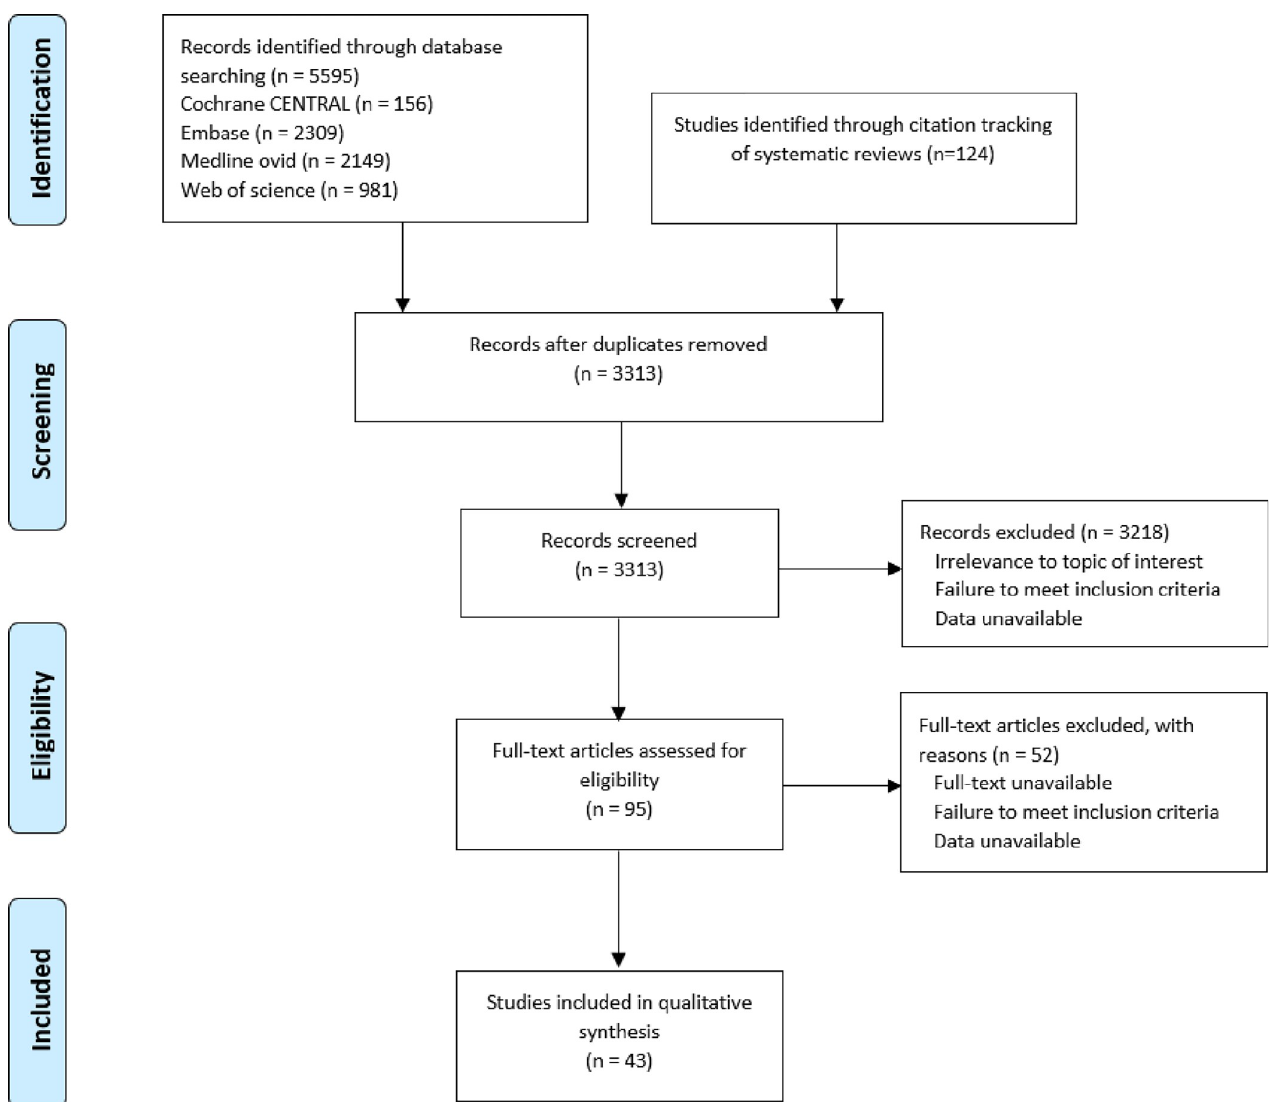
Fig 1. Flowchart of study selection. PRISMA Flowchart for the identification, screening, eligibility and inclusion of studies [134].